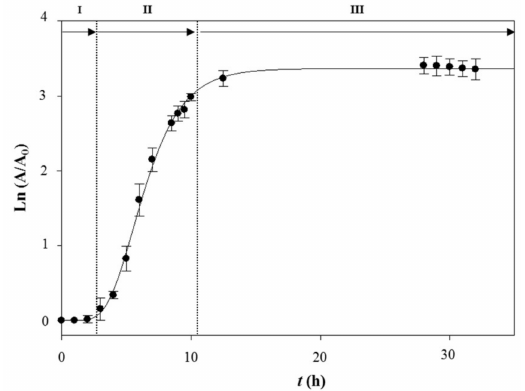
Figure 1. Time course profile of Bacillus sp. CCLBH 1053 in NB medium. All data were determined in triplicate. I —Lag phase; II —Log phase; III —Stationary